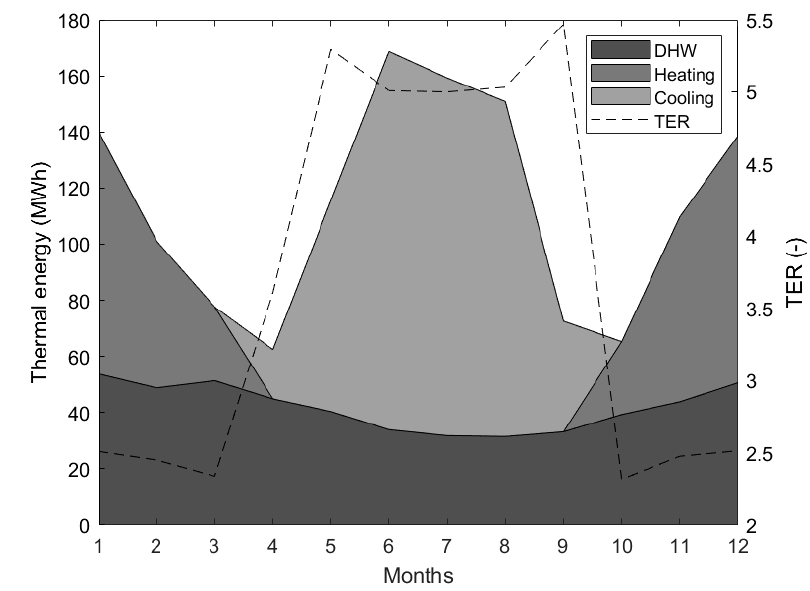
The thermal energy demand at the distribution system and the total energy ratio (TER), defined as the ratio of total thermal energy demand to overall electricity consump- tion, are presented in Figure 7. Figure 6. Electricity consumption and generation. Figure 6. Electricity consumption and generation.